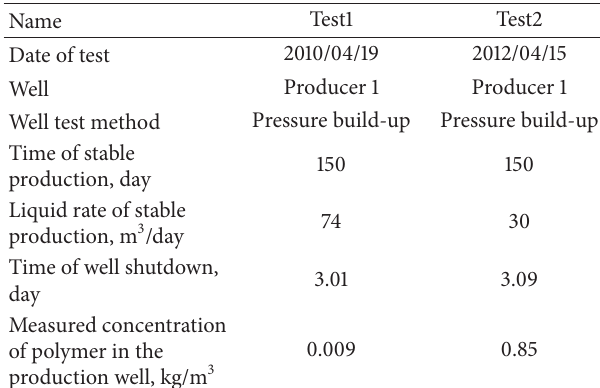
Table 4: Details of the well tests.